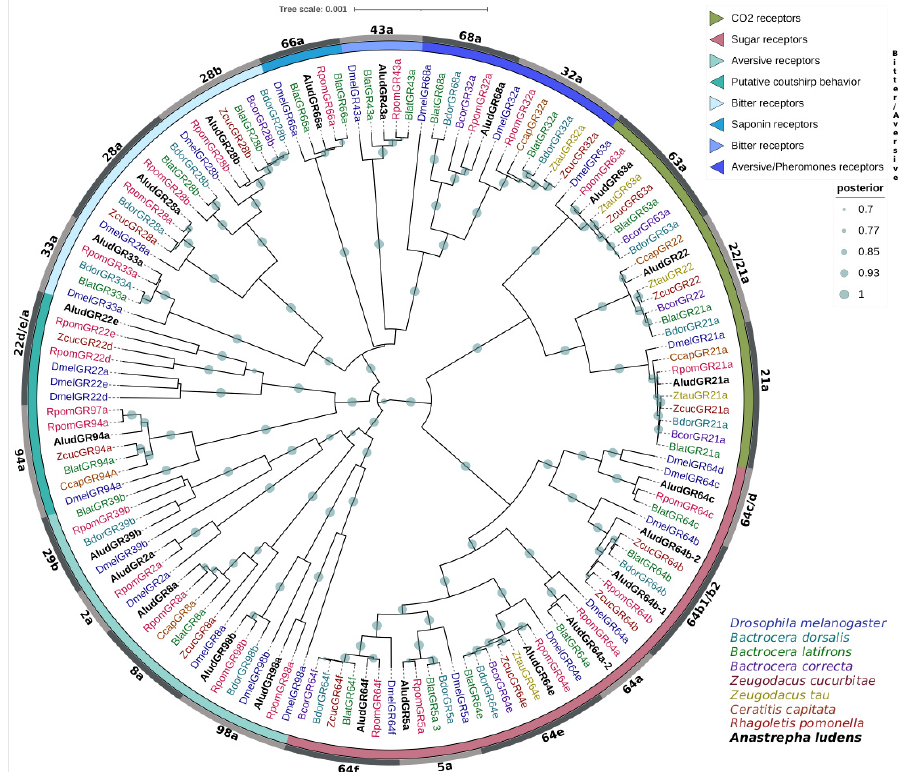
Figure 6. Bayesian phylogenetic analysis of candidate GRs from Anastrepha ludens with homologs from seven Tephritidae species and Drosophila melanogaster . Distinct colors represent clusters of AludGRs members based on putative functions reported in previous studies. Gray bars delimit branch expansions of AludGRs and their orthologues. Circles showed posterior probability values higher than 70%.